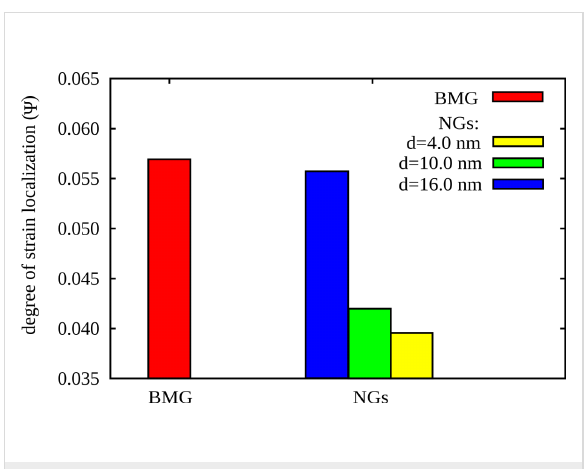
Figure 3: The ψ values for a BMG in comparison to three NGs with grain sizes of 4 nm, 10 nm and 16 nm, respectively, after plastic defor- mation to an overall strain of